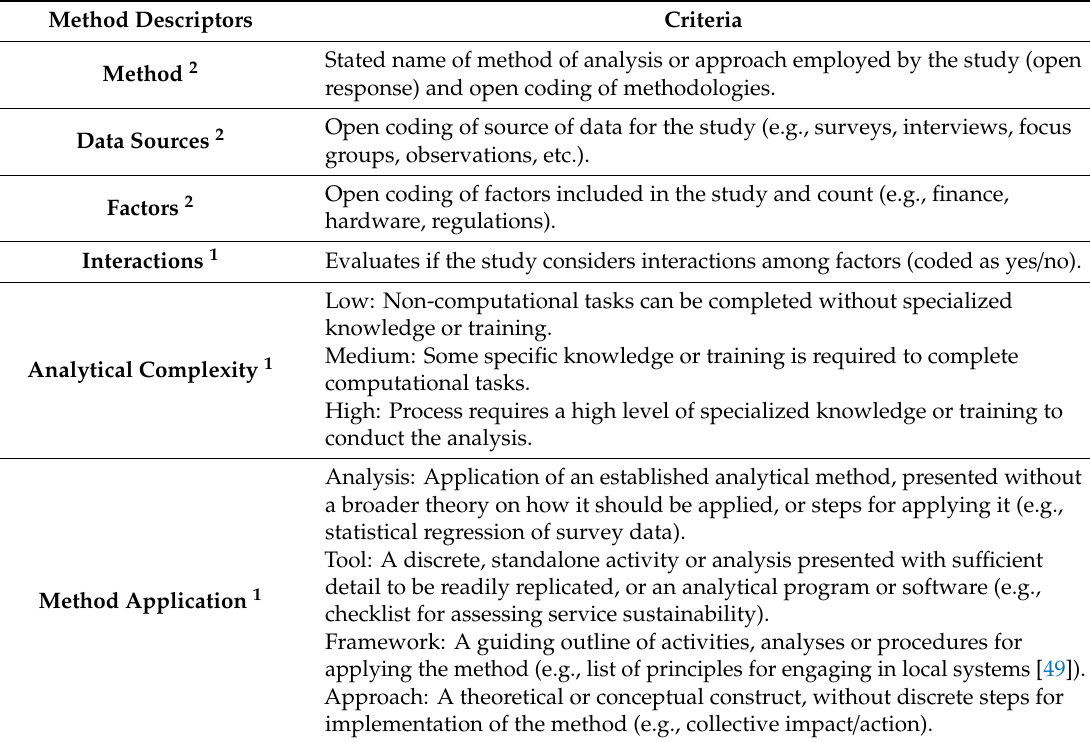
Table 1. Descriptors and criteria for assessing the method